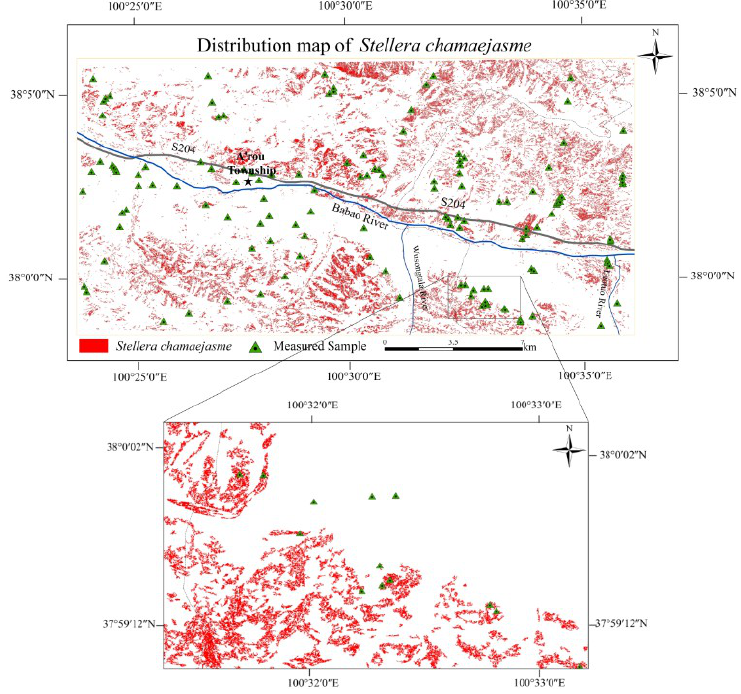
Figure 10. Distribution map of S. chamaejasme in the study area.